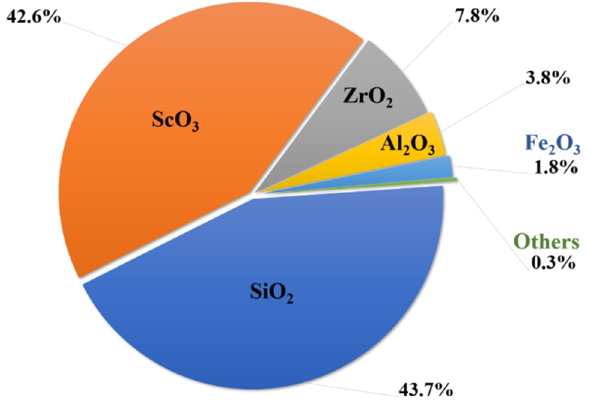
Figure 6. The elements contained in the scandium ore from Madagascar, adapted from